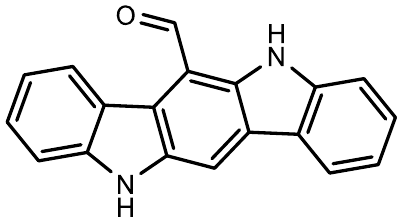
Figure 7. Structure of 6-formylindolo(3,2- b )carbazole ( 11 ) .